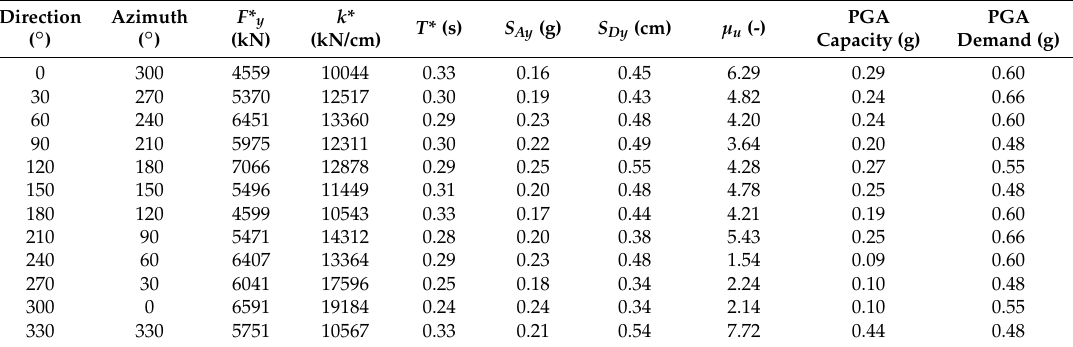
Table 3. Assessment of the admissible peak ground acceleration (PGA).